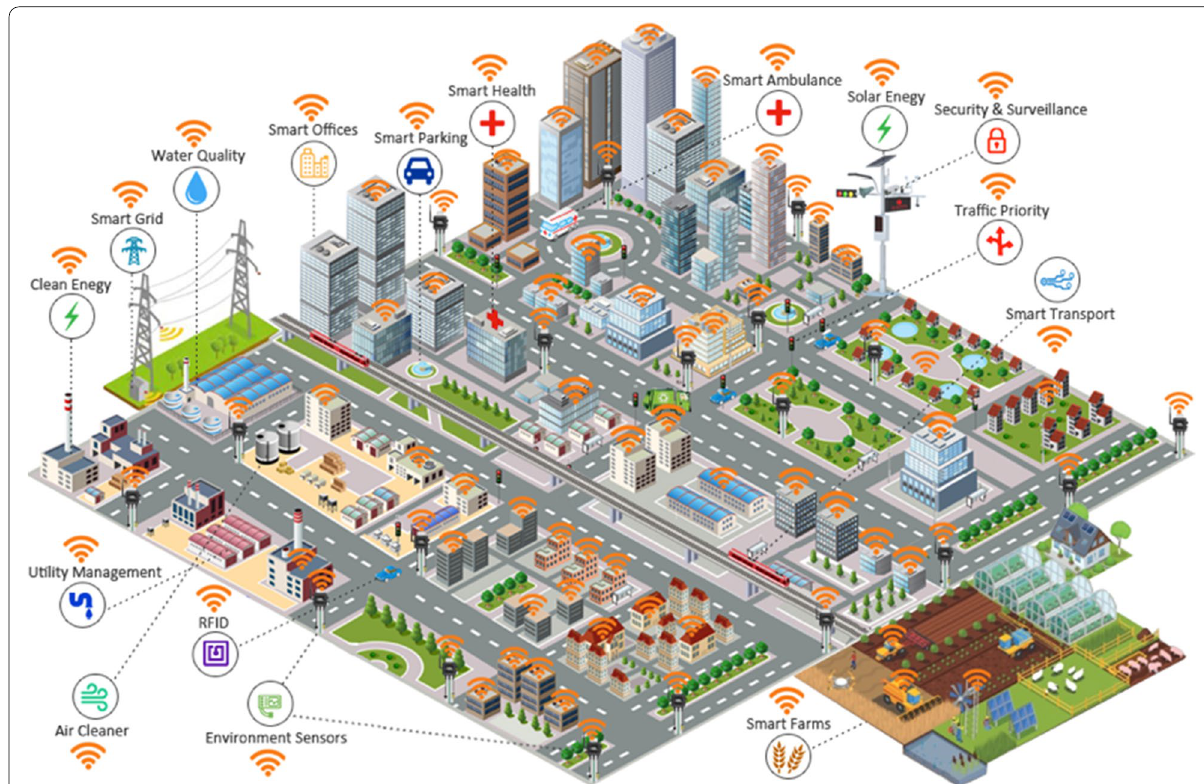
Fig. 3 Cloud Ecosystems in Critical